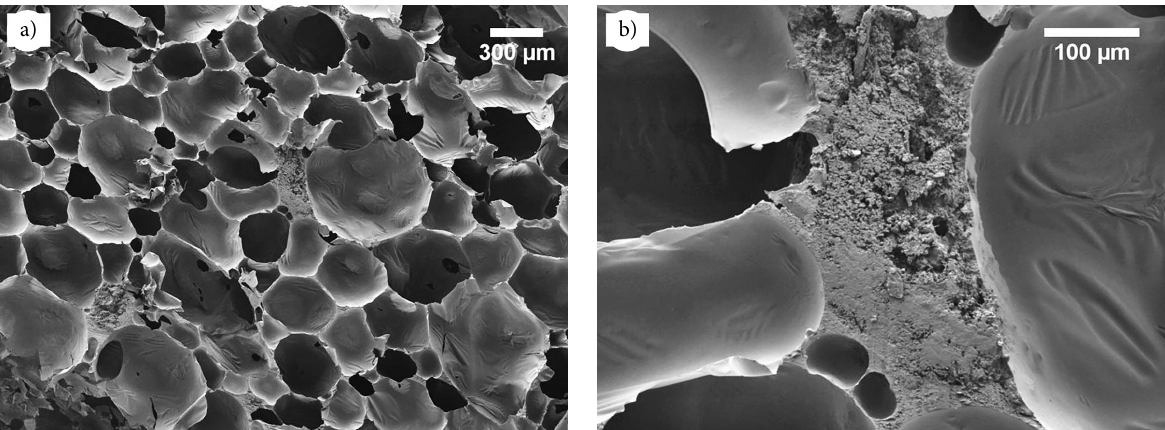
Fig. 4. Microstructure of 10 pbw of RPG extended and 20 wt.% of PWS filled polyurethane foam composite parallel to the foaming direction: a) at ×35 magnification; b) agglomerate of PWS particles at